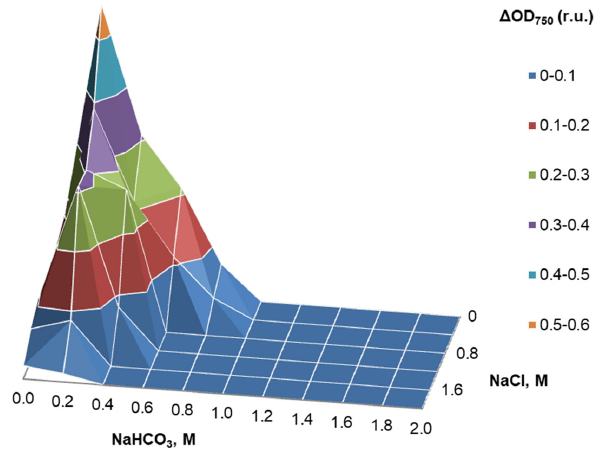
Figure 8. Growth of Neochlorella semenenkoi IPPAS C-1210 in the concentration matrix of NaHCO 3 and NaCl. One representative experiment out of two is shown.